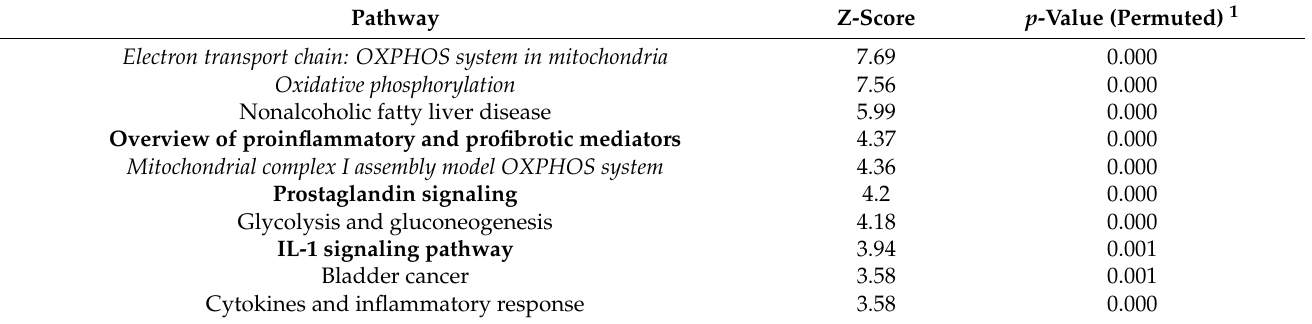
Table 4. Top 10 significant pathways for the Phenion ® Full-Thickness Skin model exposed to RIVM 2 preparation. DEGs selected by moderated t -test with adjusted p -value < 0.05 were used for ORA in PathVisio. Pathways related to immune and inflammatory response and those related to cellular respiration are shown in bold and in italics, respectively.